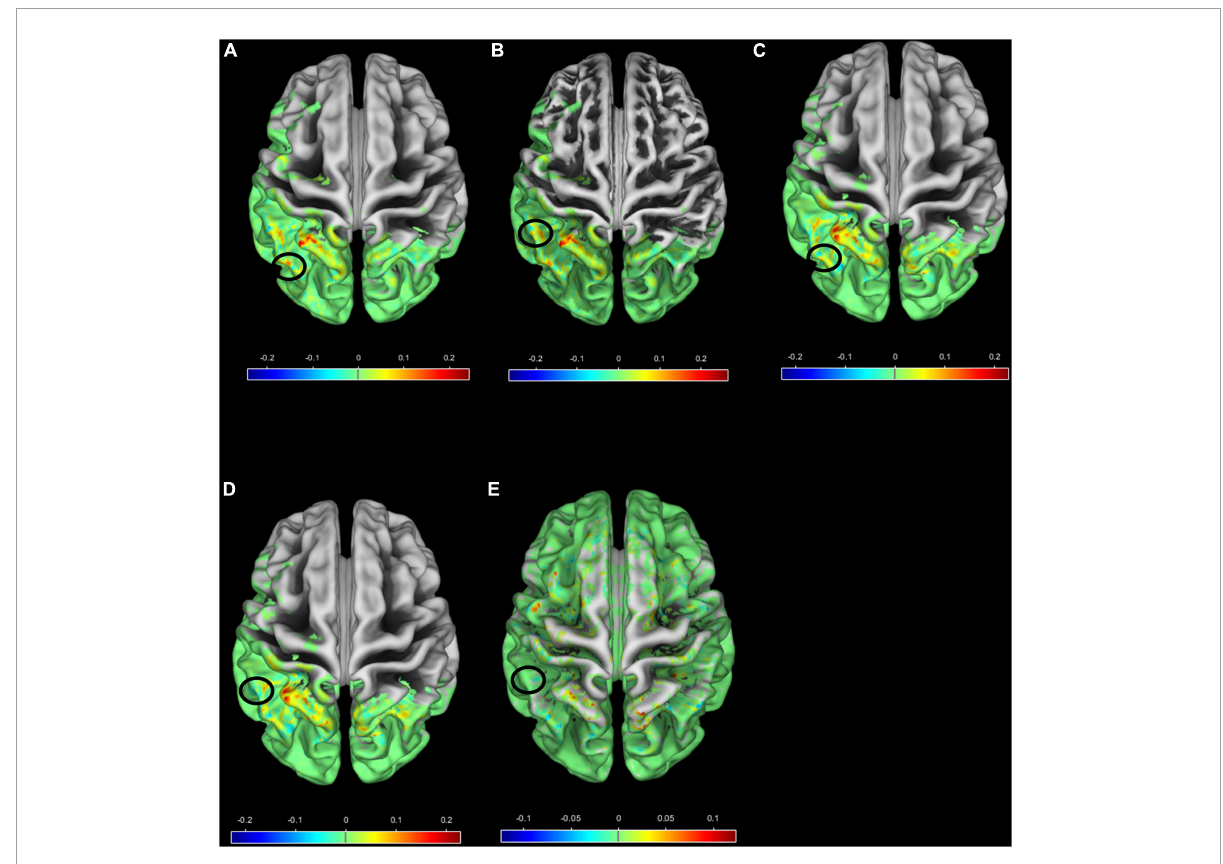
FIGURE8 Surface overlay of the mean correlation with Morlet wavelet for (A) FEP scale 94, (B) FEP scale 96, (C) CHR scale 94, (D) CHR scale 96 and (E) HC scale 96. The color scale represents the range of the correlation, higher (lower) correlation means smooth (sharp) cortical folding, and the black circles indicate regions with different mean correlation between groups (A) vs. (C) , (B) vs. (D) , (B) vs. (E)